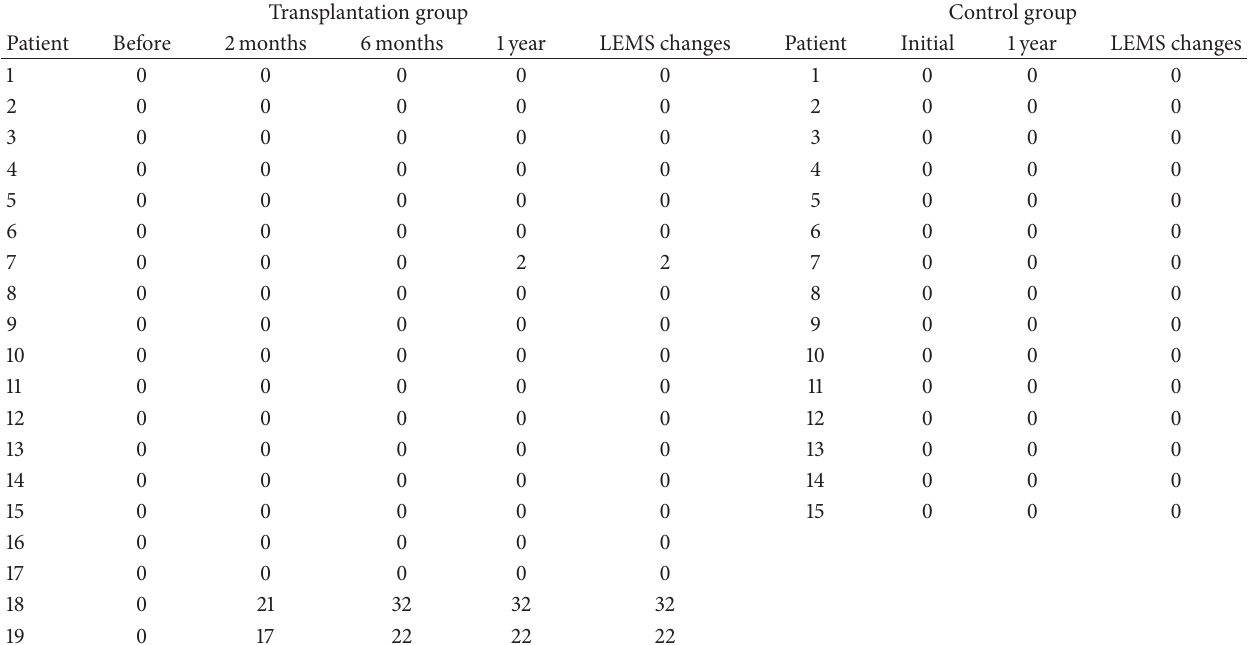
Table 7: AMS lower extremity motor score (LEMS).